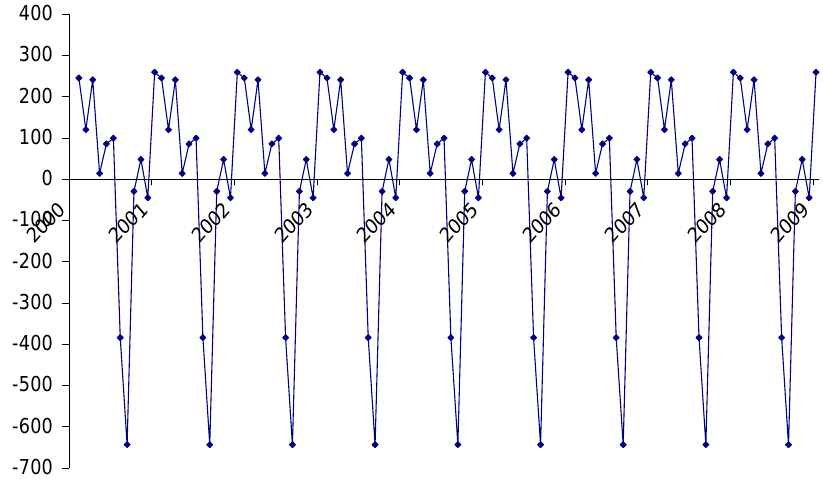
Figure 3 Model 3 - Seasonal Component